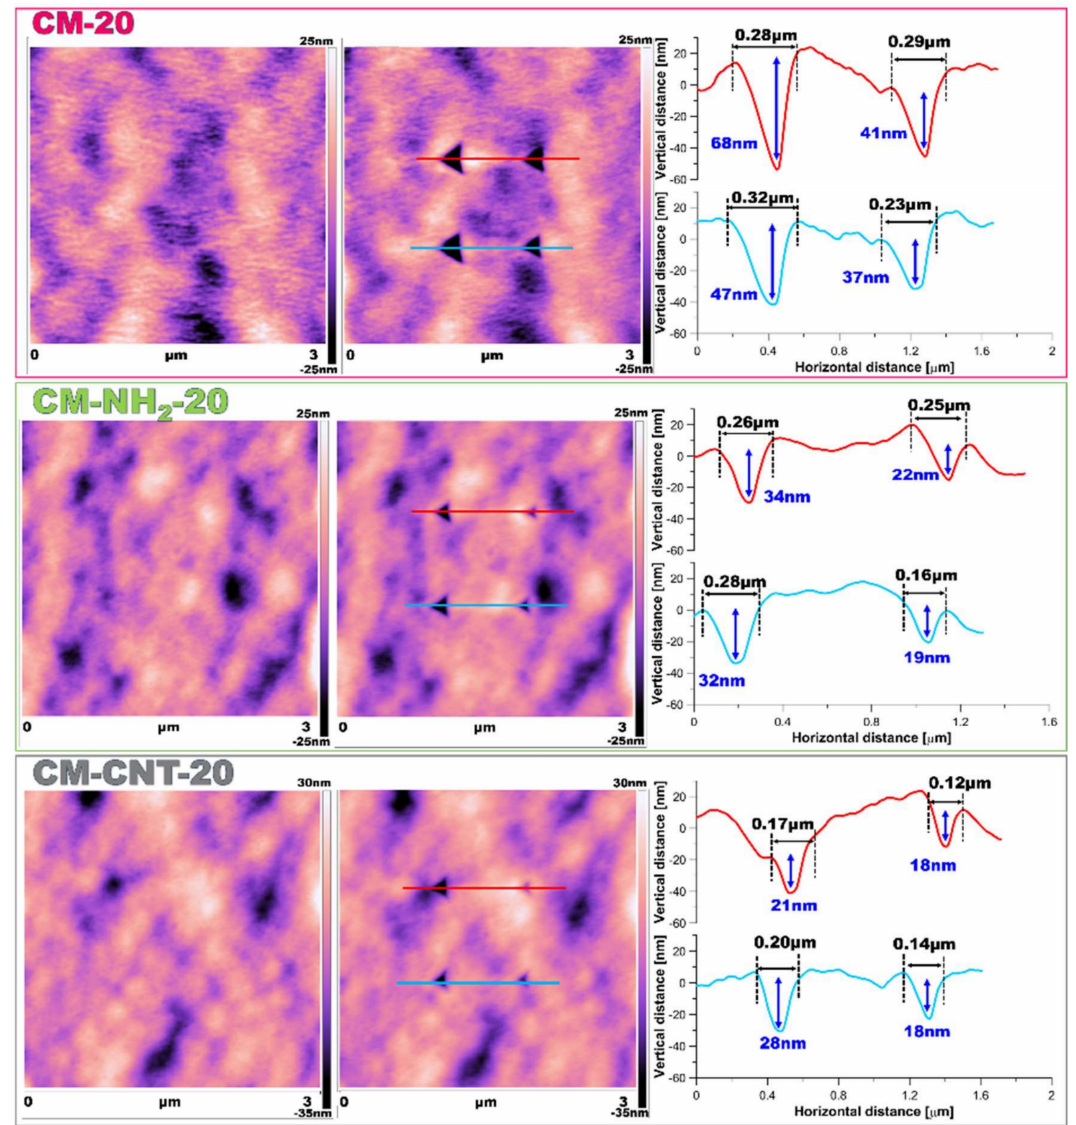
Figure 10. Nano-indentation test for pristine and modified samples of 20 nm